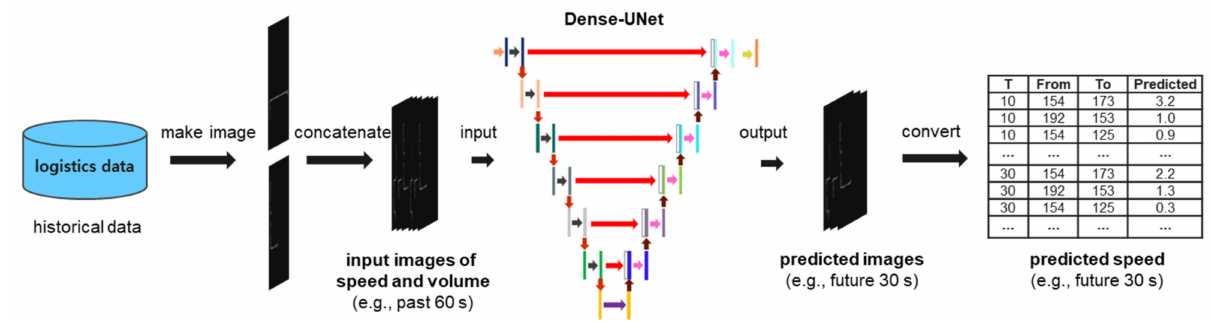
Figure 3. The procedure of the proposed method.